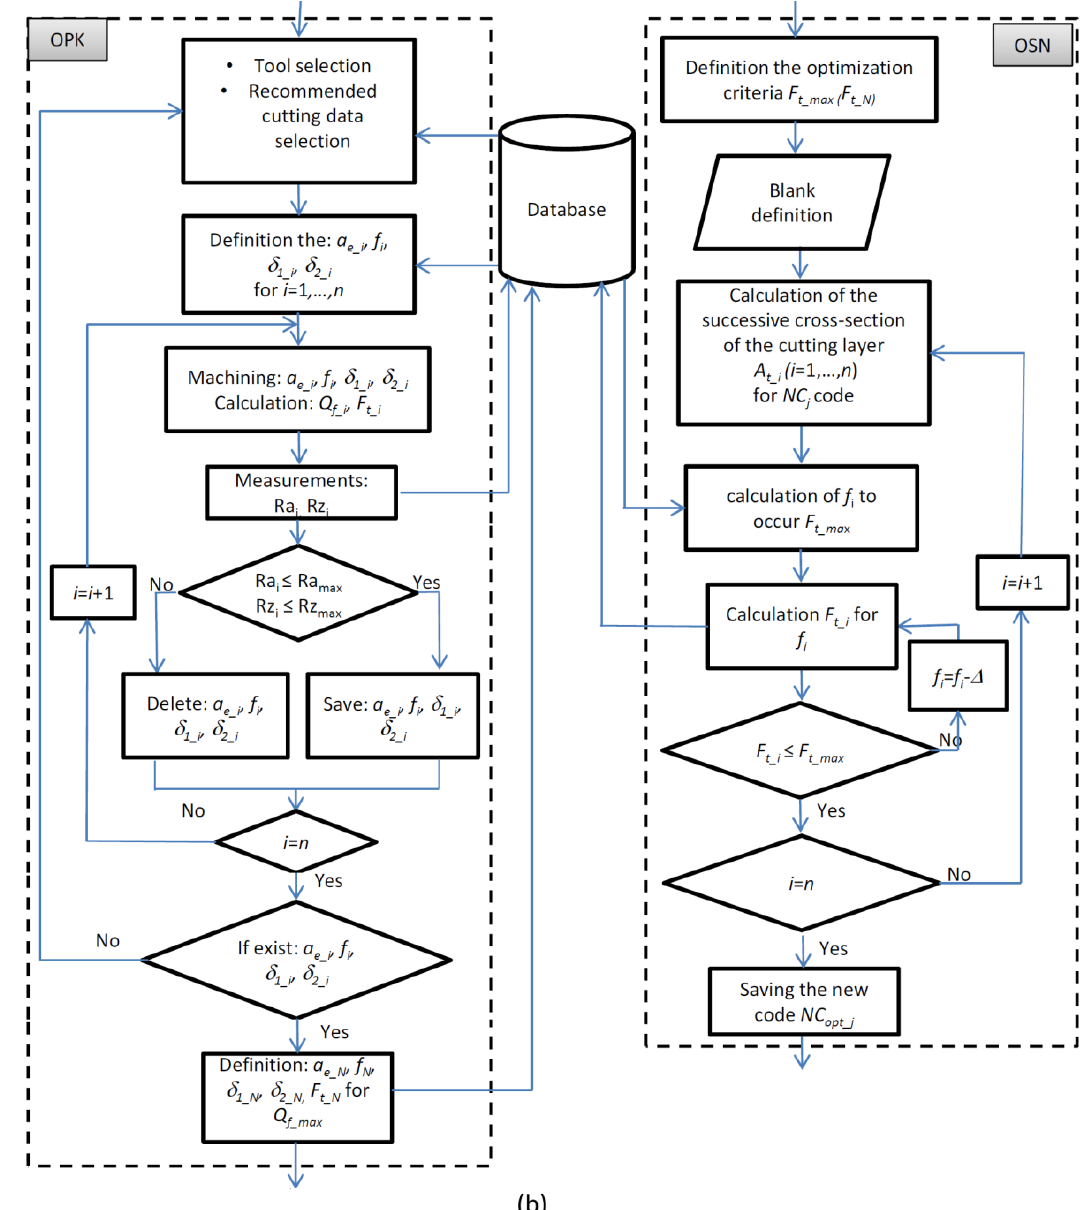
Figure 3. Optimization algorithm: ( a ) main algorithm; ( b ) OPK and OSN stage.